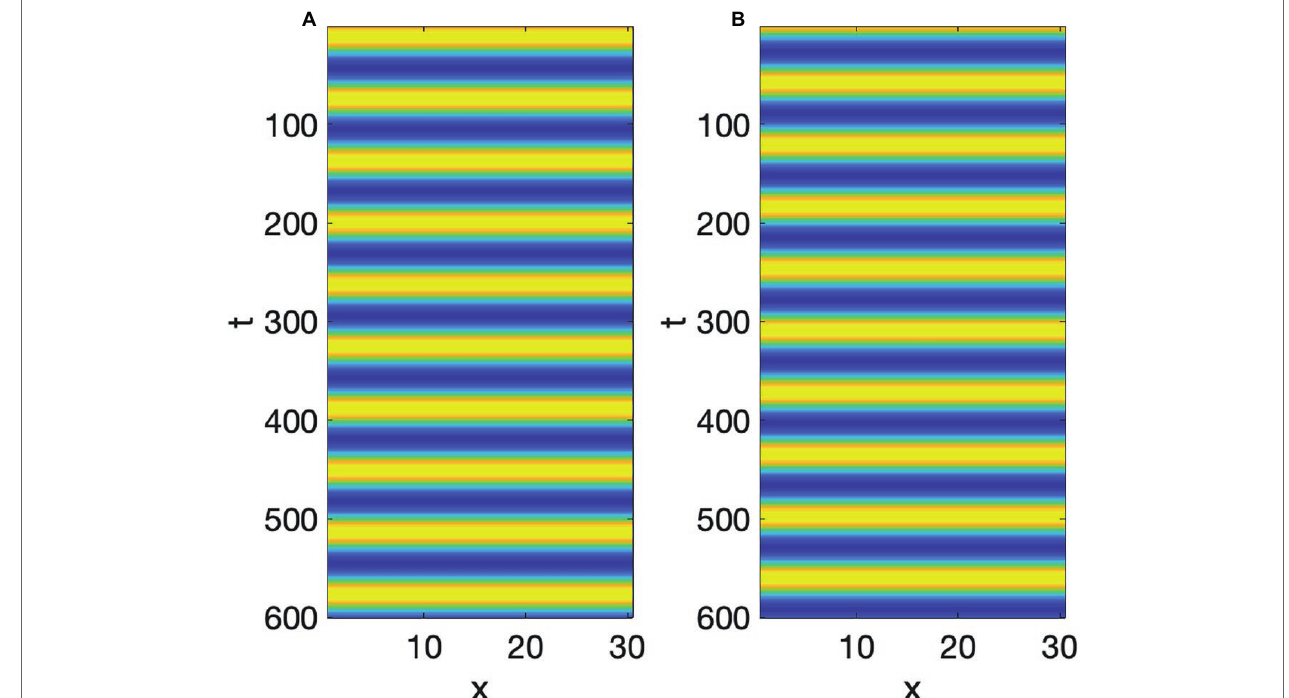
FIGURE 5 | Linear oscillator with demarcation in time: (A) A , (B) S